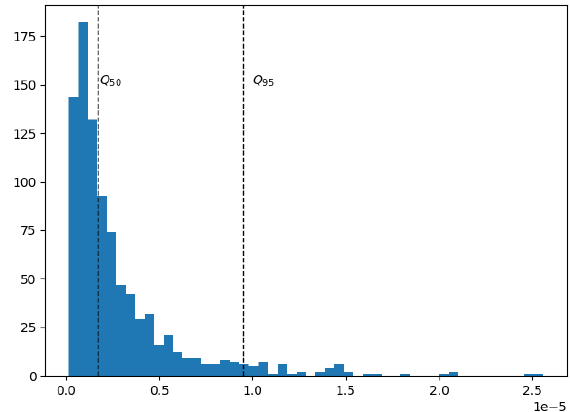
Figure 4. Histogram of the risk score distribution and marked median at 0.17e-5 and 95-quantile at